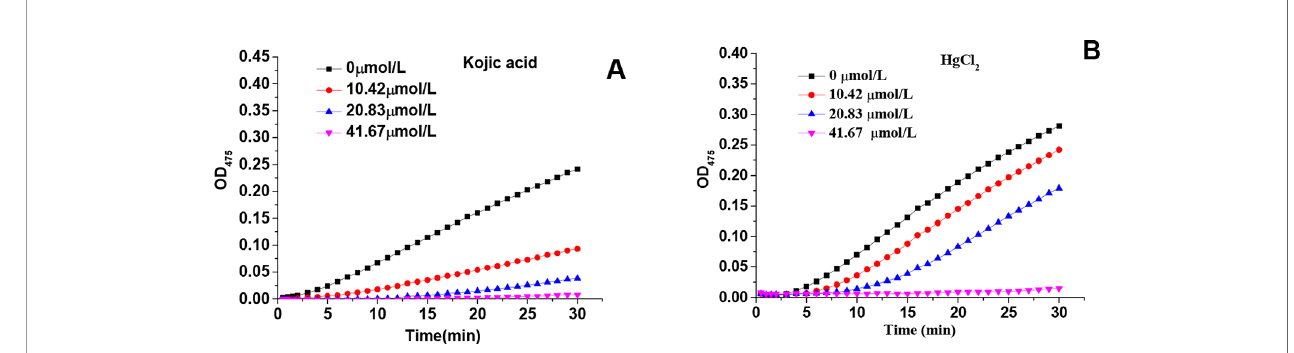
FIGURE 1 | Effects of various concentrations of kojic acid and HgCl 2 on monophenolase: progression of tyrosine oxidation by tyrosinase in the presence of various concentrations of kojic acid (A) and HgCl 2 (B) .